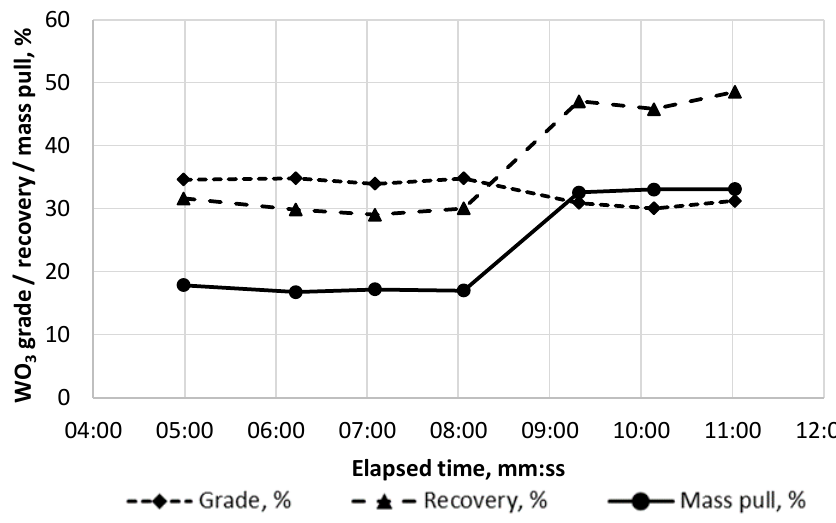
Figure 12. Results of experiments monitoring variation in concentrate grade, recovery and mass pull to concentrate outlet over time when changing wash water flowrate.